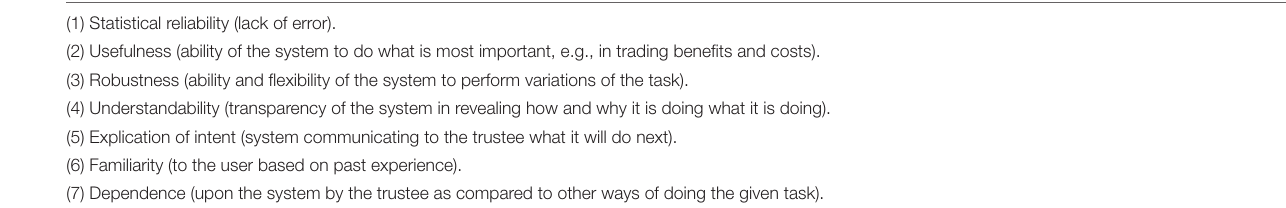
TABLE 1 | Standard definition of trust by Sheridan